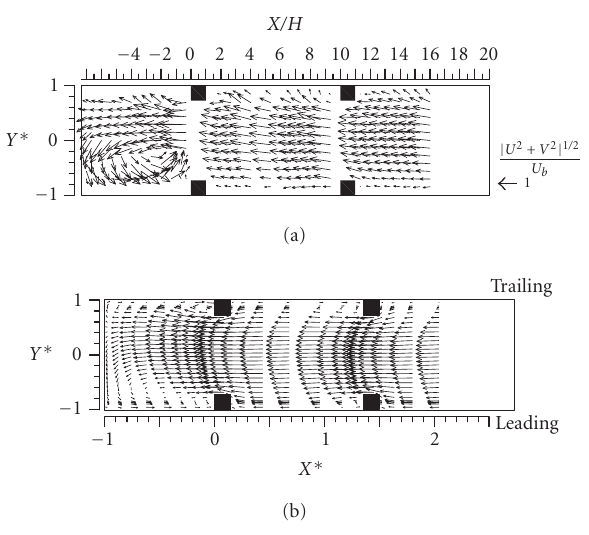
Figure 4: Mean velocity vector plots around the turn in the first pass on Z ∗∗ = − 0 . 5 for Ro = 0 . 15 and Re = 1 . 0 × 10 4 : (a) Liou et al. [1] and (b) present study.